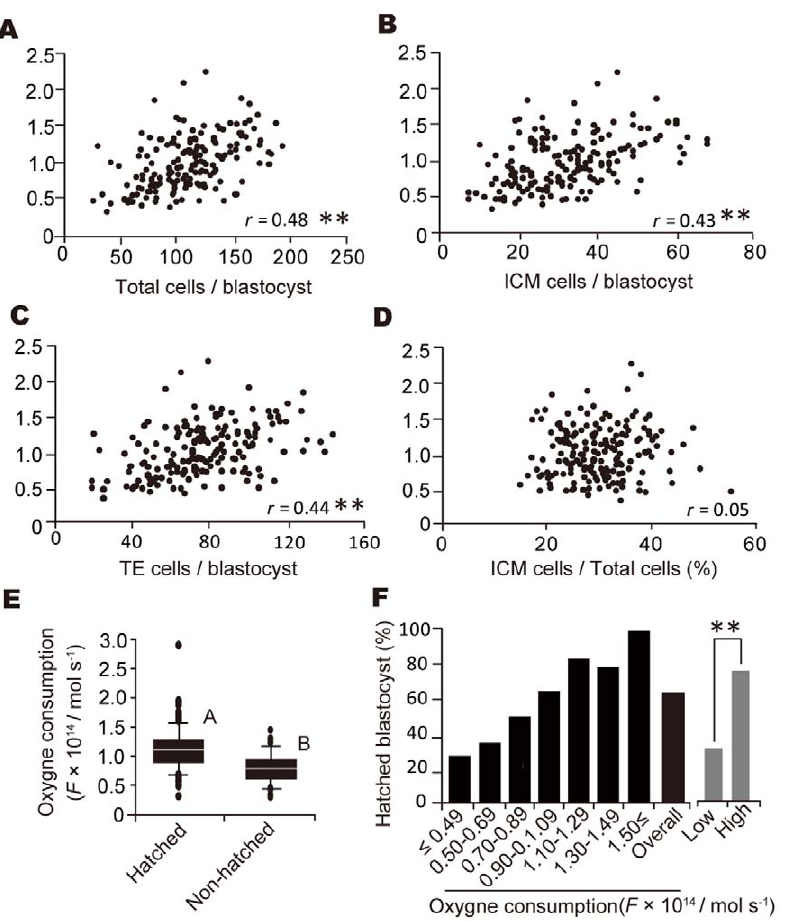
Figure 2. Correlation between oxygen consumption at the blastocyst stage and number of total (A), ICM (B), and TE (C) cells and the percentage of ICM cells relative to total cell number (A4). **Coefficient of determination, r , was statistically significant based on simple regression analysis ( P , 0.01). Relationship between oxygen consumption at the blastocyst stage and hatching after 48 additional hours of culture ( D and E ). The level of oxygen consumption was considered high or low with a cut-off of 0.84 6 10 2 14 mol s 2 1 ( E ). Double asterisks indicate